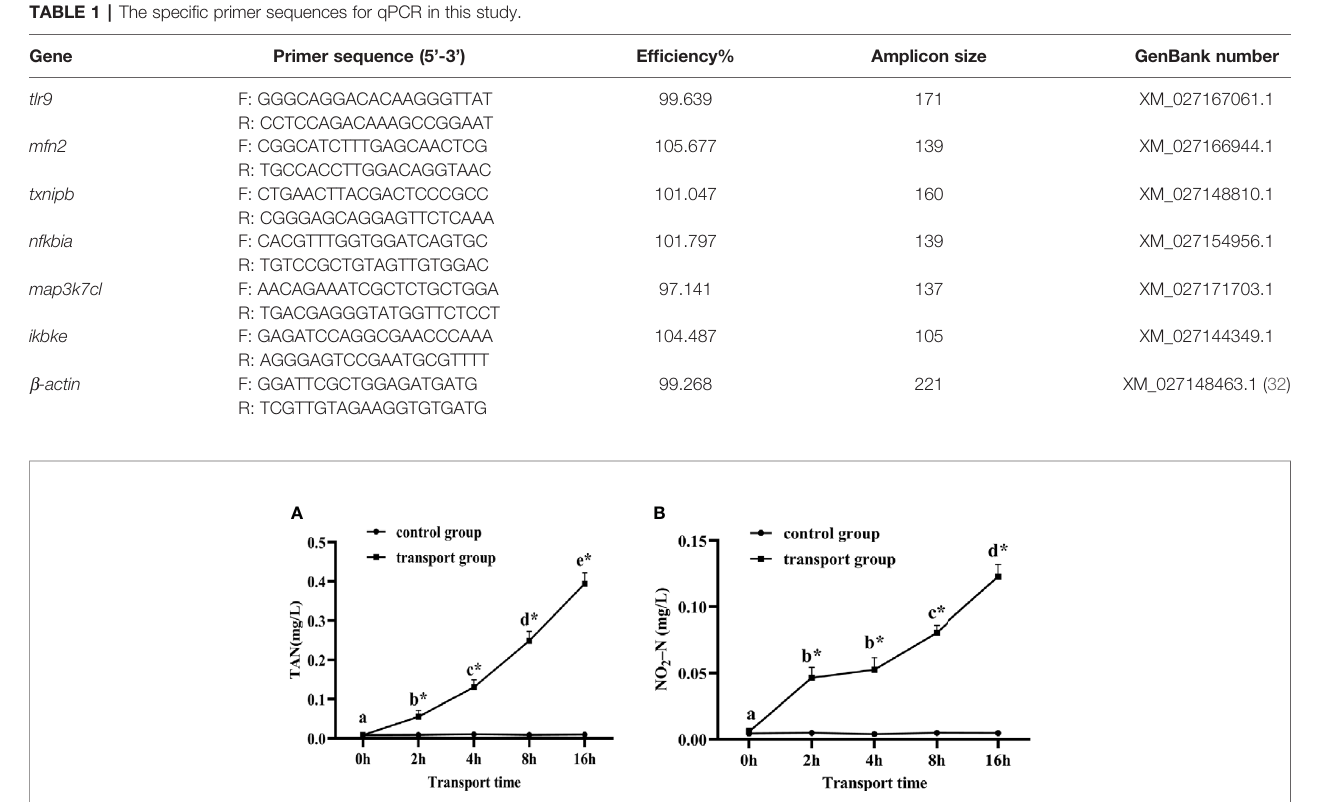
FIGURE 1 | Changes in total ammonia nitrogen (TAN) (A) and nitrite-nitrogen (NO 2 -N) (B) levels in water of fi sh during transport. stress. Values are mean ± SD ( n =12). Asterisk (*) indicates signi fi cant difference ( P < 0.05) between control group and transport group. Different small letters indicate signi fi cant differences ( P < 0.05) among sampling times in the same